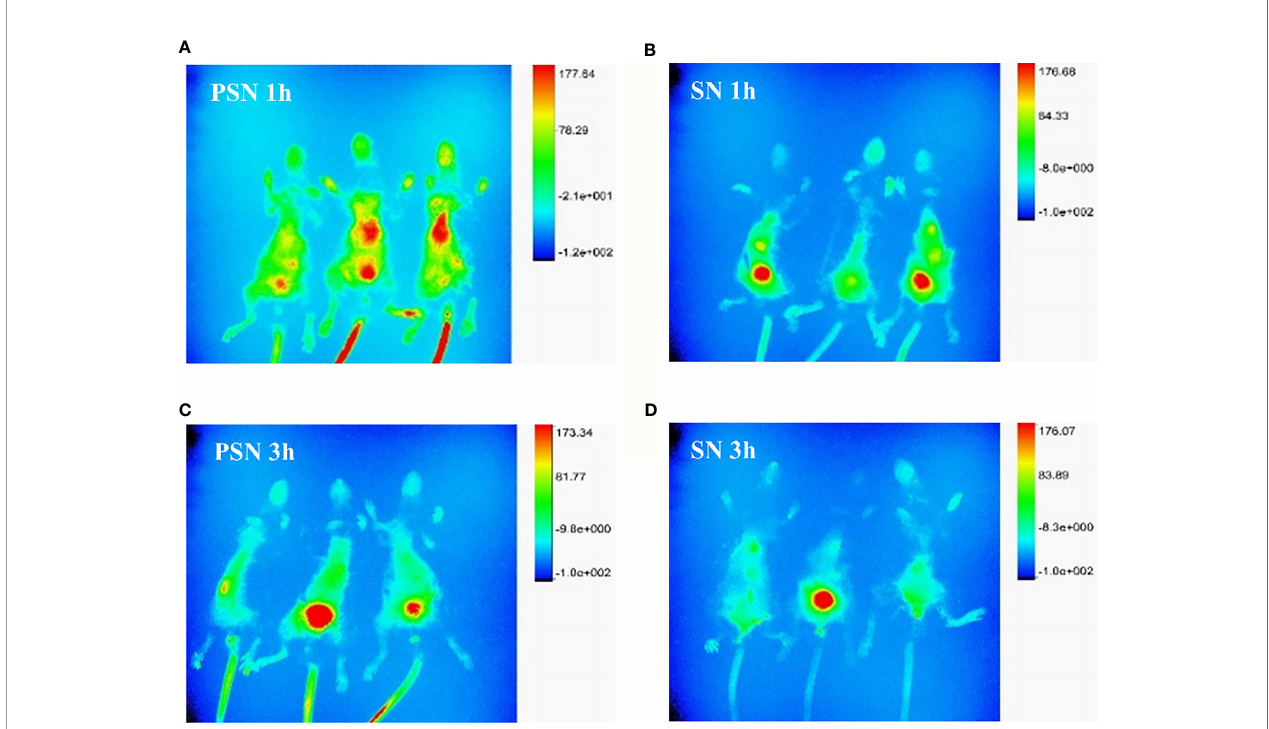
FIGURE 11 | Fluorescence distribution of live and in vivo mice tissues. (A, B) . Fluorescence distribution of 1 h in vivo imaging of mice after PSN-Cy7 and SN-Cy7 injection respectively; (C, D) . Fluorescence distribution of 3 h in vivo imaging of mice after PSN-Cy7 and SN-Cy7 injection